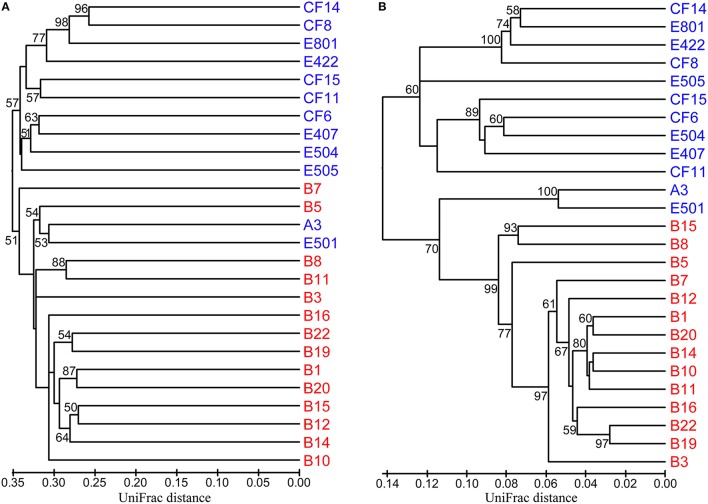
Hierarchical clustering dendrograms of the Bohai Sea and northern South China Sea sediment nifH-harboring microbial assemblages. These dendrograms were constructed by using the Fast UniFrac unweighted (A) and weighted and normalized (B) Jackknife Environment Clusters statistical methods with the use of the NifH protein sequence data obtained from the current study and a previous study of the nSCS (Dang et al., 2013a). The percentage supports of the classifications tested with sequence jackknifing resamplings are shown near the corresponding nodes. The Bohai Sea sampling stations are labeled in red color and the northern South China Sea sampling stations are labeled in blue color.